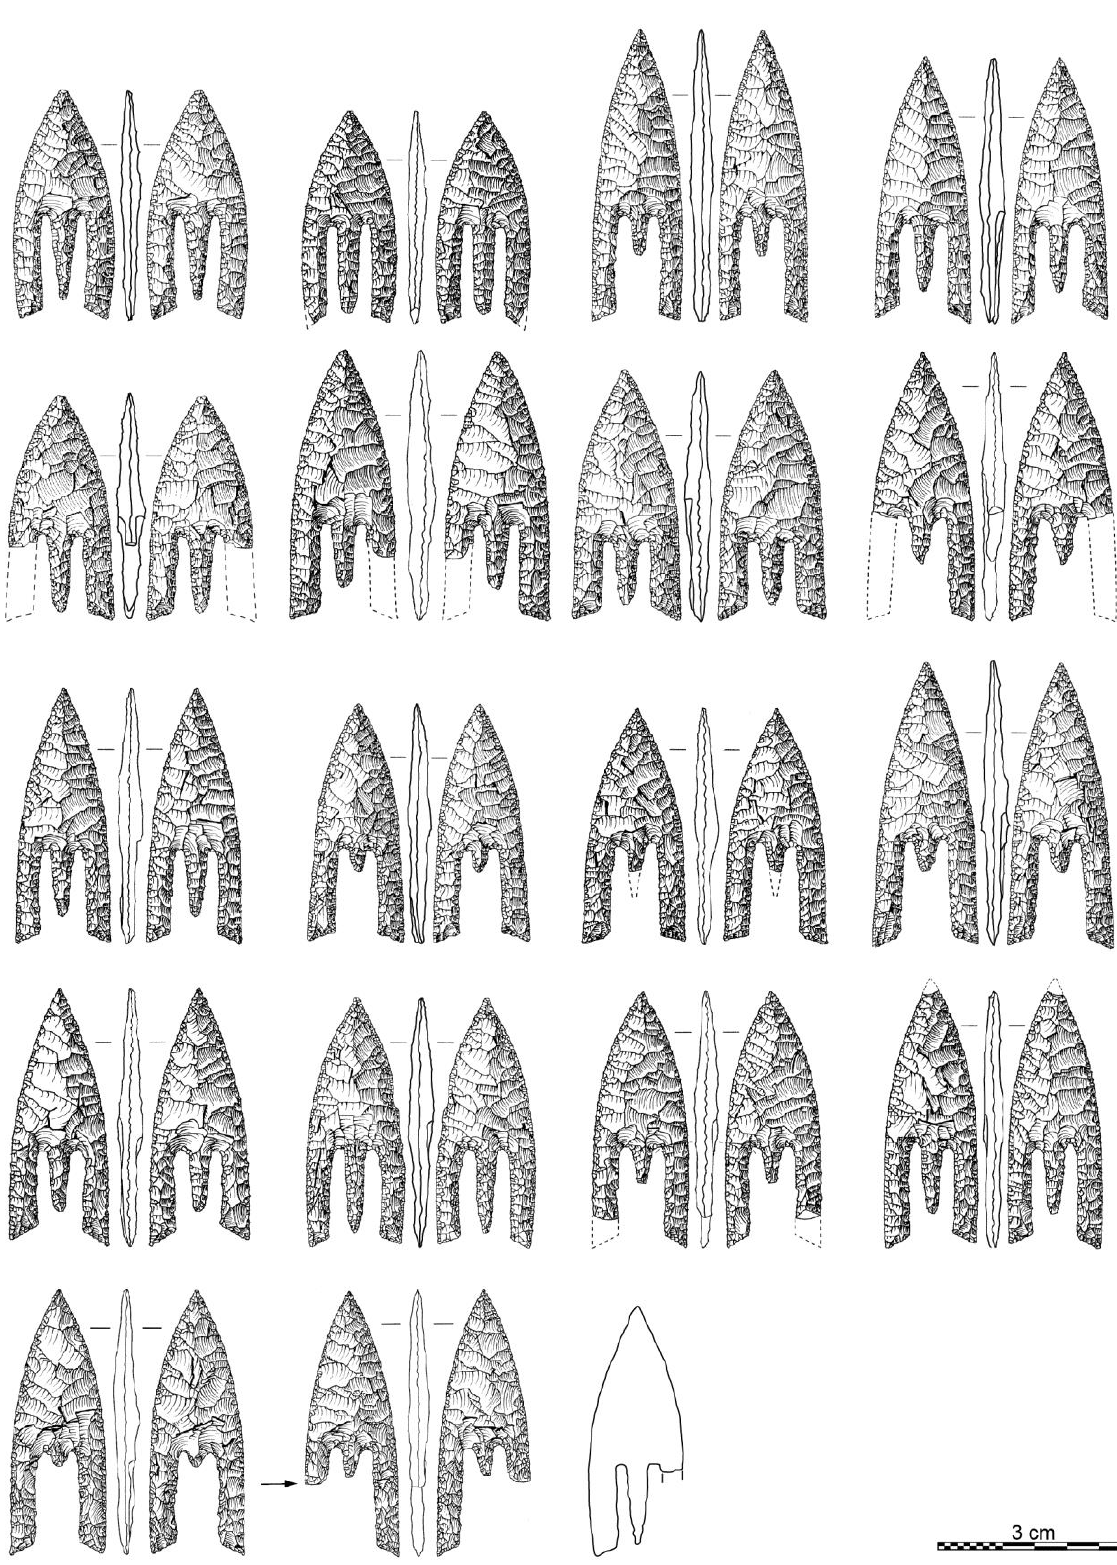
Figure 9. The arrowheads from Graeoc 2 barrow, Saint-Vougay, Finistère: an example of the variety of retouch with transverse, parallel or multidirectional retouch combination (drawings C.